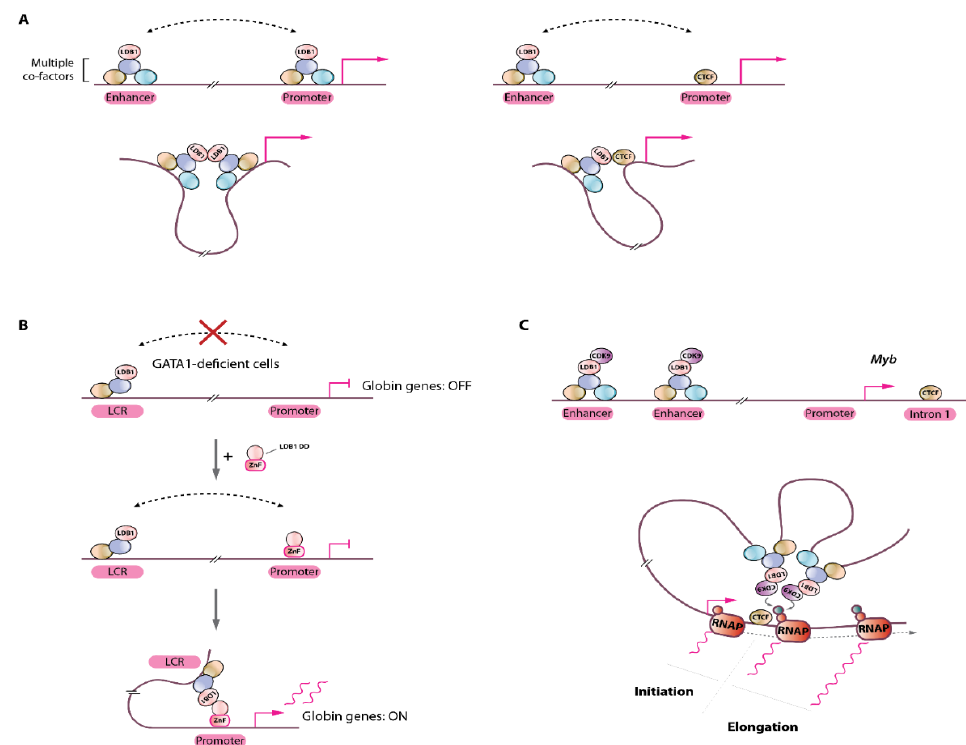
Figure 4. Chromatin loop formation by the LDB1 transcription factor. ( A ) Left, distally-bound LDB1-complex (containing several DNA-binding TFs and co-factors) at enhancers can interact with promoter-bound complexes by self-interactions (via its homodimerization domain); Right, LDB1 can also interact with promoter-bound CTCF through heterodimerization, bringing enhancer sequences to close proximity to promoters for efficient transcriptional activation. ( B ) in GATA1-deficient cells, the LDB1 complex does not bind the globin gene promoter but interacts with the LCR enhancers (via the TAL1 TF). Note that LDB1 does not directly bind DNA. In this context, chromatin looping does not occur and the globin genes are silent/poorly activated. Artificial tethering of the LDB1 dimerization domain (DD) through fusion to a Zinc-finger (ZnF) domain engineered to bind the globin promoter sequence results in re-establishment of long-range interaction with the distal LCR and activation of globin genes transcription. ( C ) Schematic representation of the Myb locus with LDB1-complex bound distal enhancers. Recruitment of the CDK9 kinase at enhancer sites by the LDB1-complex stimulates transcription elongation at Myb intron 1 by looping through local phosphorylation of RNA polymerase II (RNAP). Red and green circles on RNAP: Ser5- or Ser2-phosphorylated RNAP C-terminal domain, respectively.